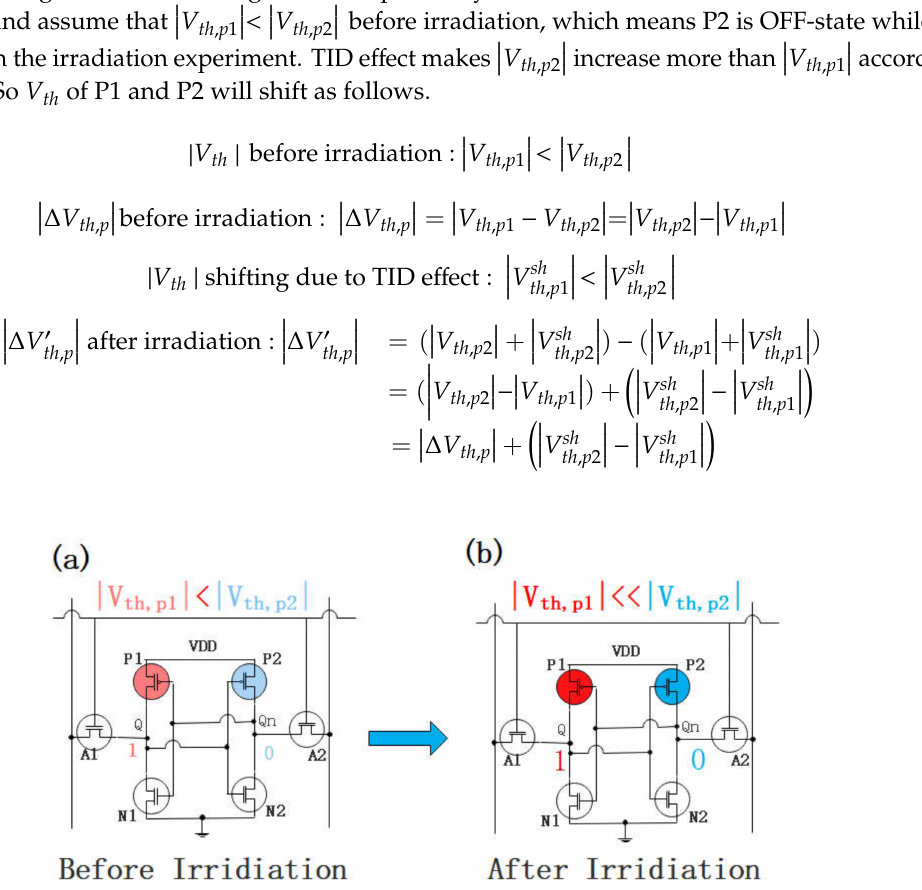
Figure 3. ( a ) Strong cell before irradiation and ( b ) Strong cell after irradiation. If a strong cell